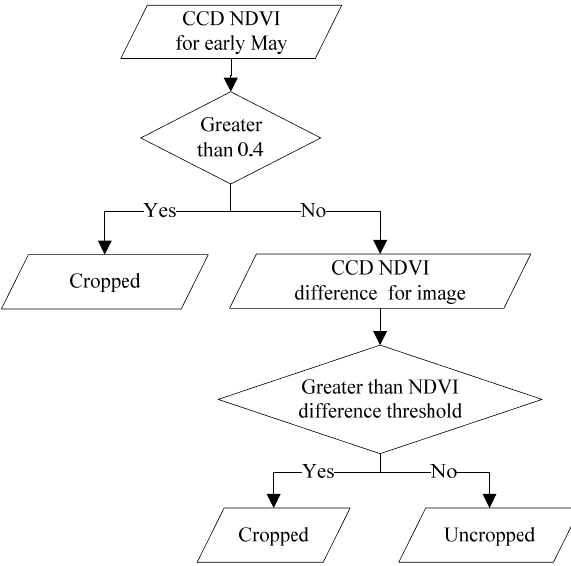
Figure 3. The decision tree for cropped and uncropped arable land